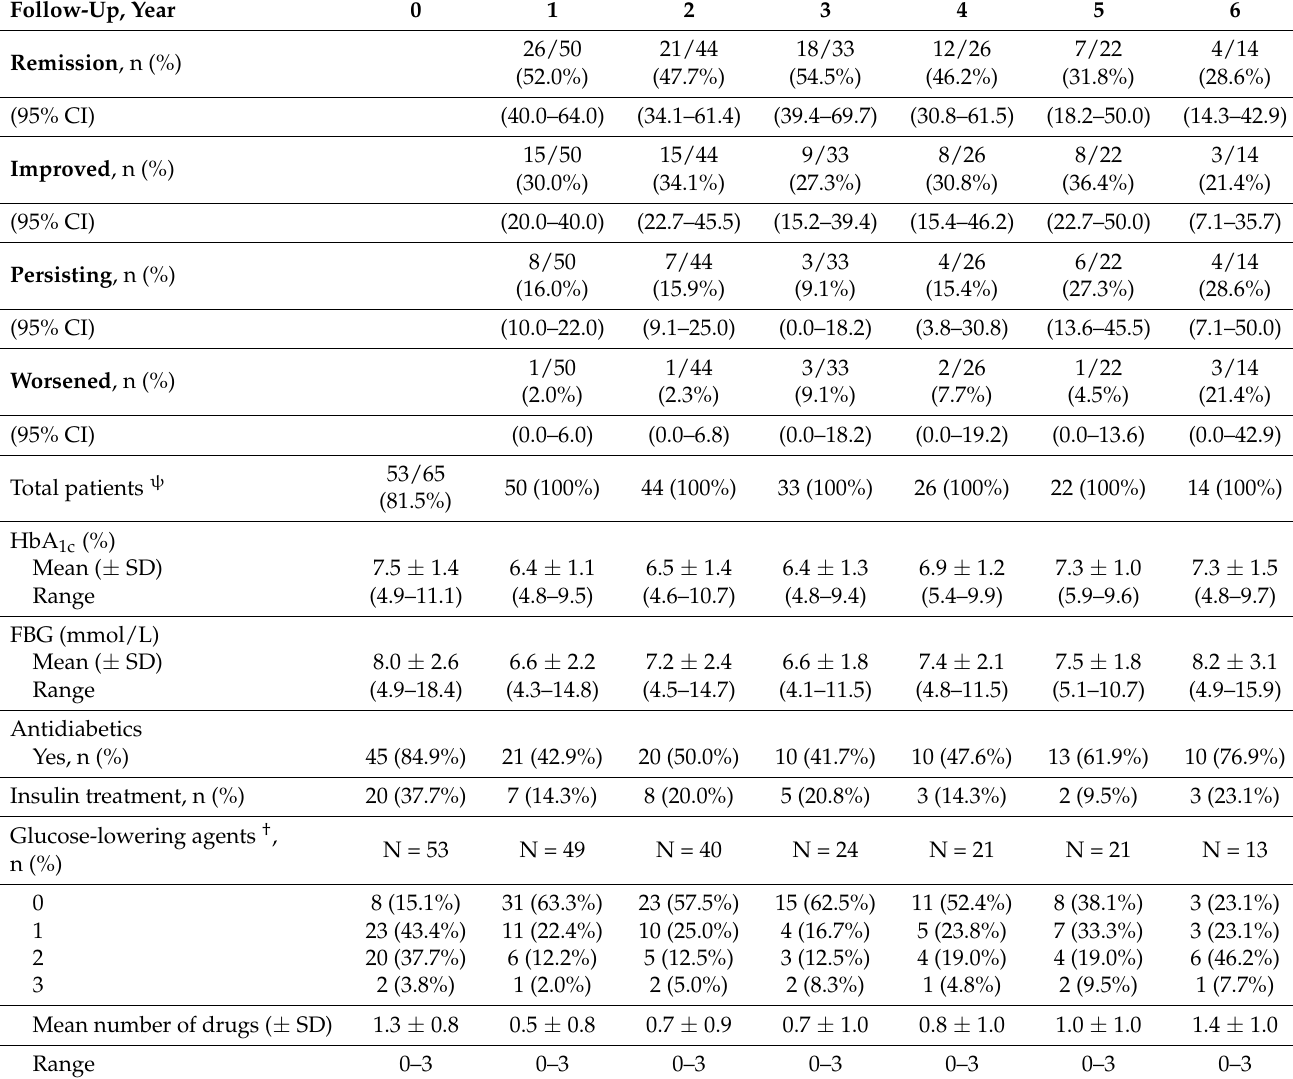
Table 4. Yearly remission, improved, persisting and worsened rates of type 2 diabetes mellitus a